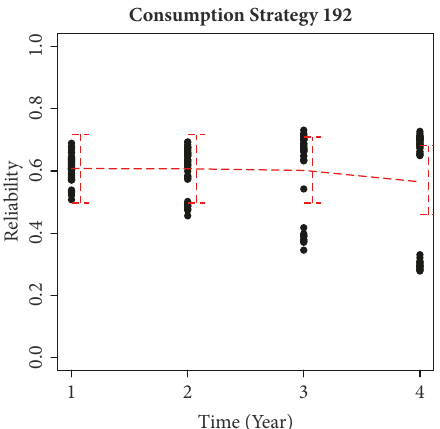
Figure 15: Reliability over time for the final selected strategy (192)